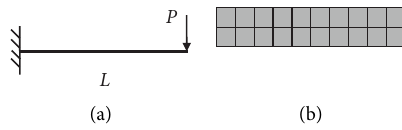
Figure 7: Long cantilevered plate model. (a) Geometric model. (b) Mesh model.